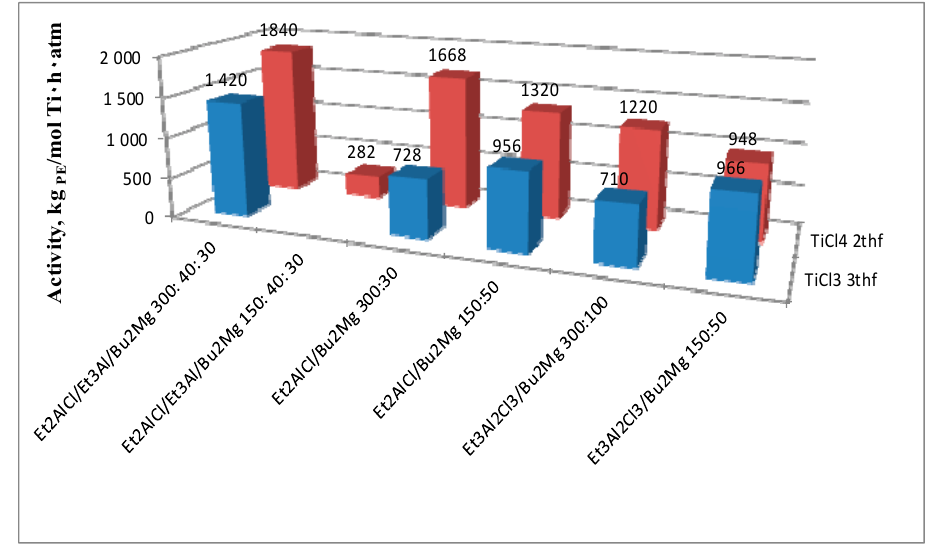
Figure 4. Activities of catalytic systems with TiCl 3 and TiCl 4 tetrahydrofuran complexes versus the composition of the activation mixture.